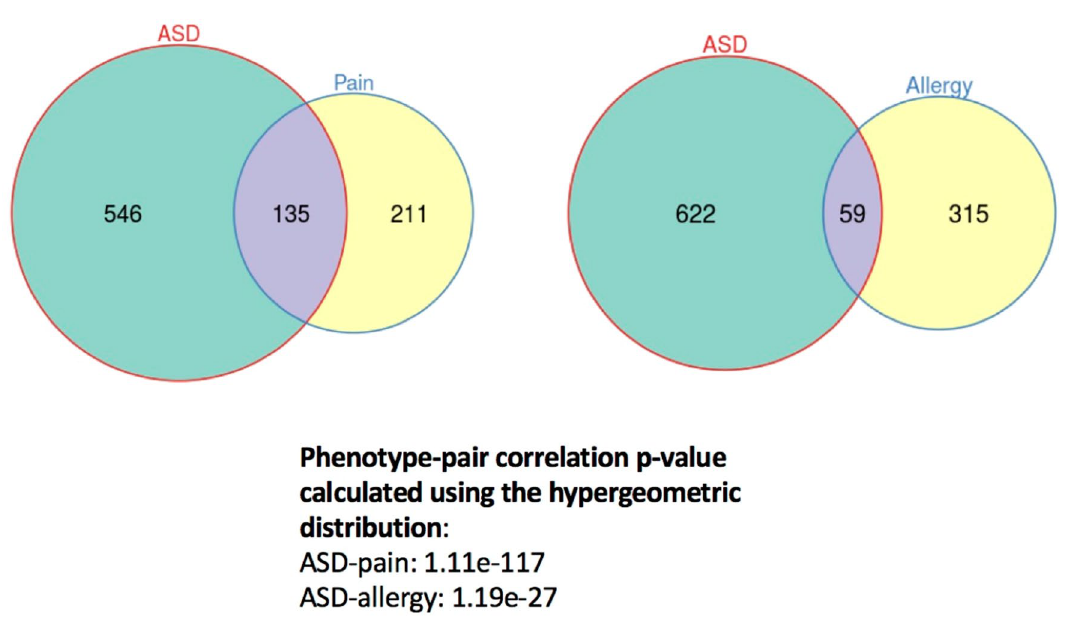
Figure 4. Genetic correlations between autism spectrum disorder (ASD) and the other two comorbid phenotypes (allergy, pain). The numbers within each circle indicate the number of candidate genes corresponding to different phenotypes (ASD, pain sensory conditions, and allergy-related conditions) based on the literature, and the size of the circles are proportional to the number of candidate genes in each set of Venn